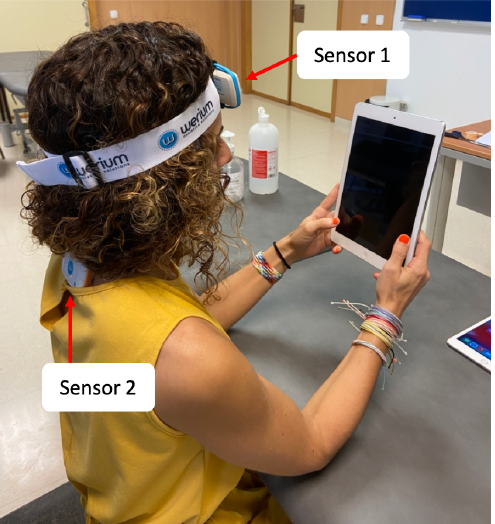
Figure 5. One of the participants ready to perform the experiment with the Apple iPad Air . ENLAZA inertial sensors placed on the forehead (see Sensor 1) and on T1–T2 thoracic vertebrae (see Sensor